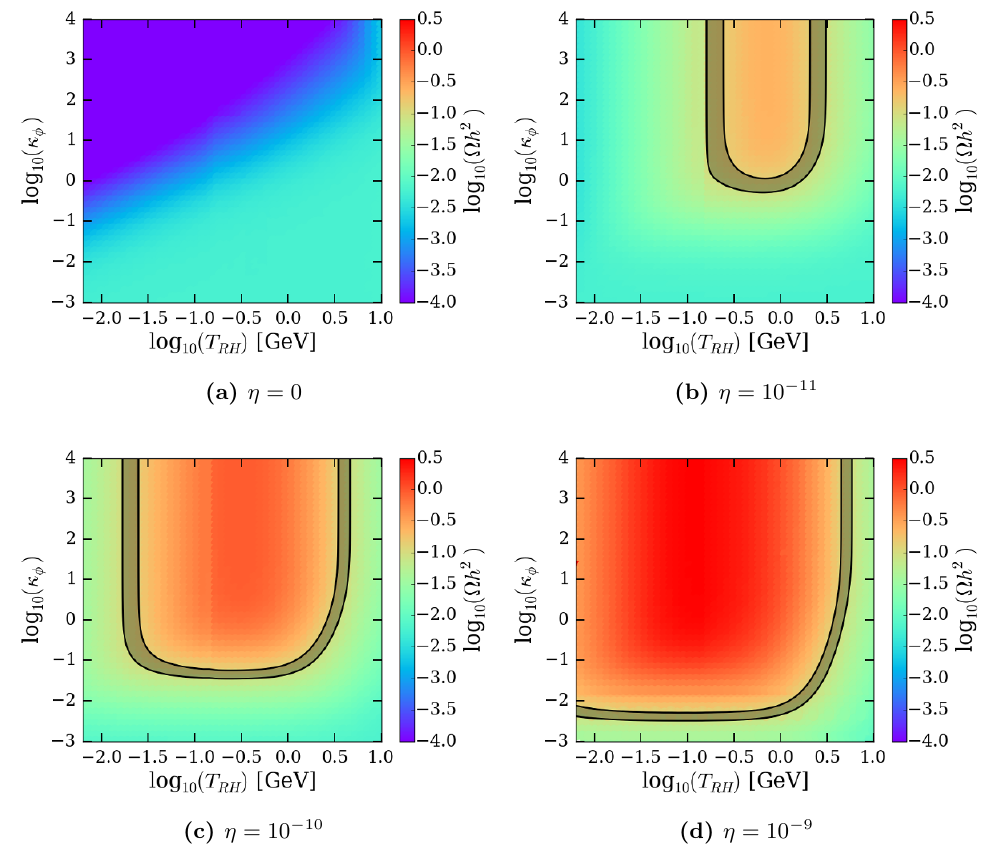
Figure 6. The e(cid:11)ect of varying (cid:17) on log